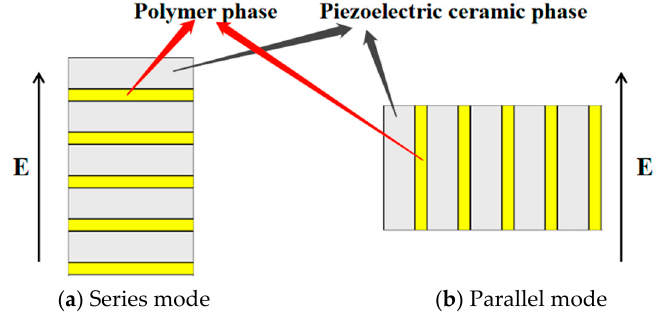
Figure 1. Two connection modes of 1-3 piezoelectric composites.